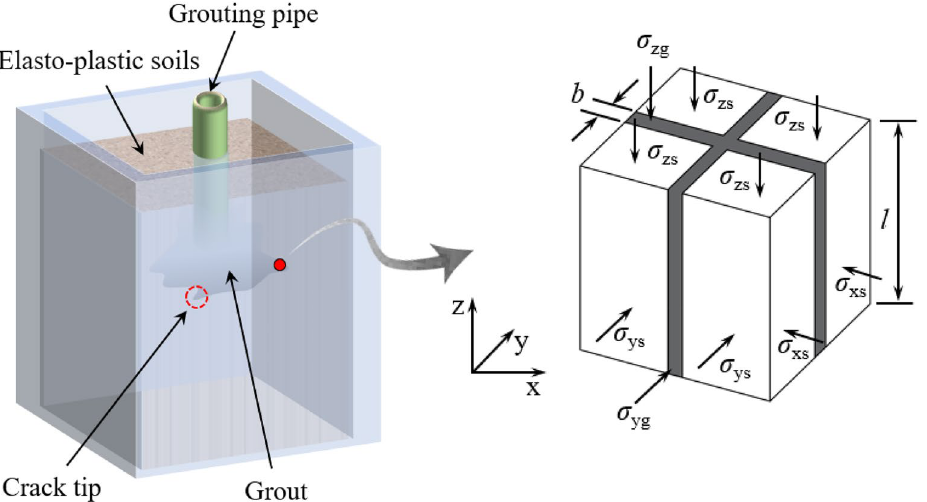
Figure 4. Conceptual model of theoretical procedure.